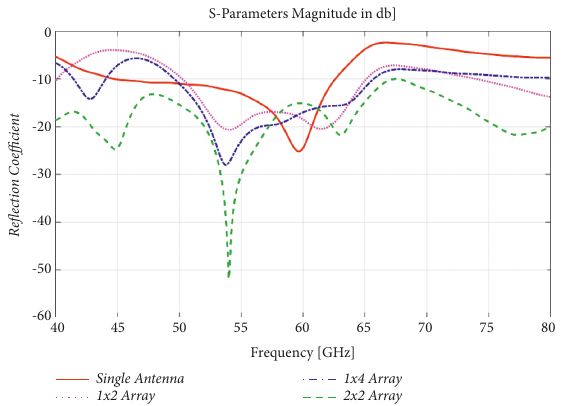
Figure 30: Return loss comparison for different